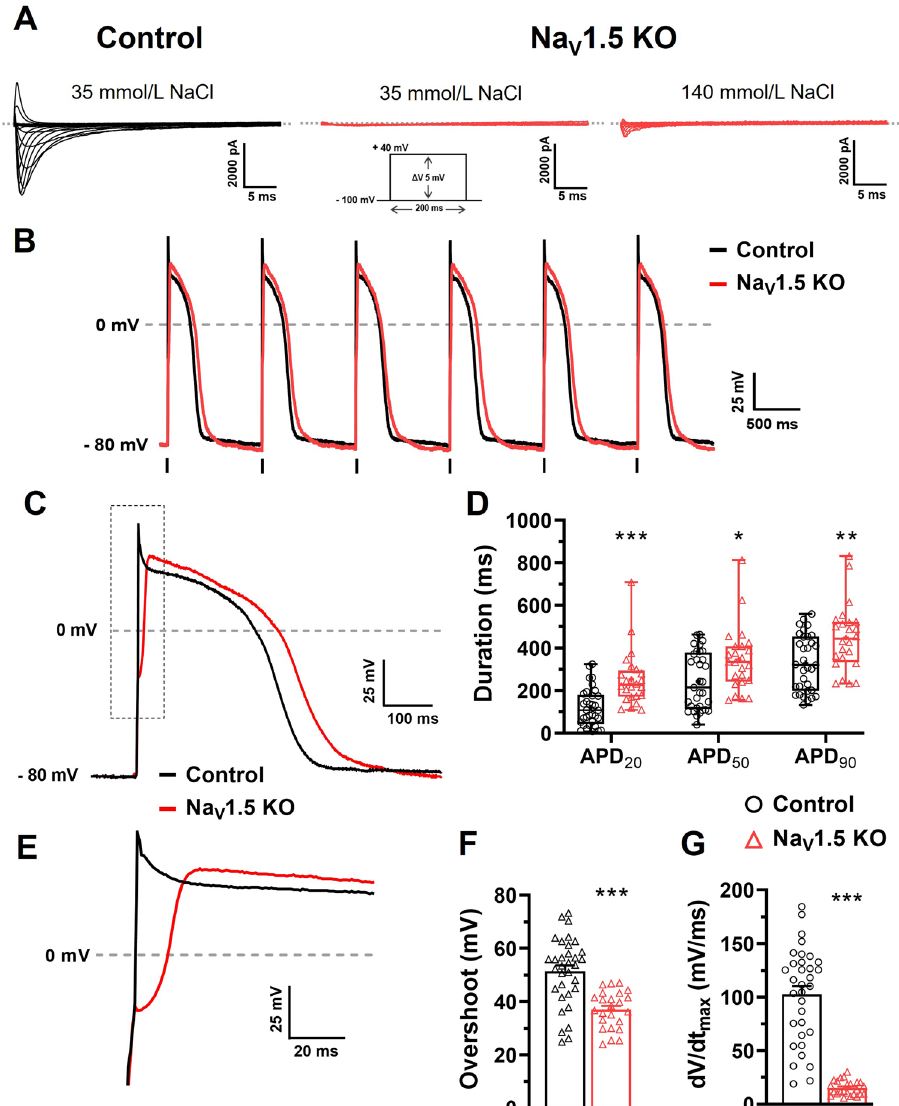
Figure 3. Electrophysiological characterization of Na V 1.5 KO iPSC-CMs. ( A ) Representative Na + currents recorded in control and Na V 1.5 KO iPSC-CMs with 35 or 140 mM NaCl in the external solution. The dashed line represents zero current. The currents were obtained using 200 ms pulses from − 100 to + 40 mV in + 5 mV increment. ( B ) Superposed train of APs from control and Na V 1.5 KO at 1 Hz. Vertical bars at the bottom of the traces indicate the 3 ms stimulation pulse. ( C ) Close-up view of one AP showing the increase in the APD for Na V 1.5 KO. ( D ) Box and whiskers summarizing the median (with quartiles and min to max values) of APD at 20 %, 50 %, or 90 % of repolarization at 1 Hz. * p < 0.05, ** p < 0.01, *** p < 0.001 as determined using a nonparametric Mann–Whitney test. ( E ) Close-up view on the rising phase of representative APs traces. ( F,G ) Bar graphs showing the mean ± SEM of overshoot ( F ) and the maximal upstroke velocity (dV/dt max ) ( G ) of APs recorded at 1 Hz. *** p < 0.001 as determined using an unpaired t-test. Control n = 33 versus Na V 1.5 KO n = 24. This figure was made using MICROSOFT POWERPOINT Version 2106 (build 14131.20278 Office, https:// docs. micro soft. com/ en- us/) and PRISM 8 Version 8.0.2 (263, https:// www. graph pad.